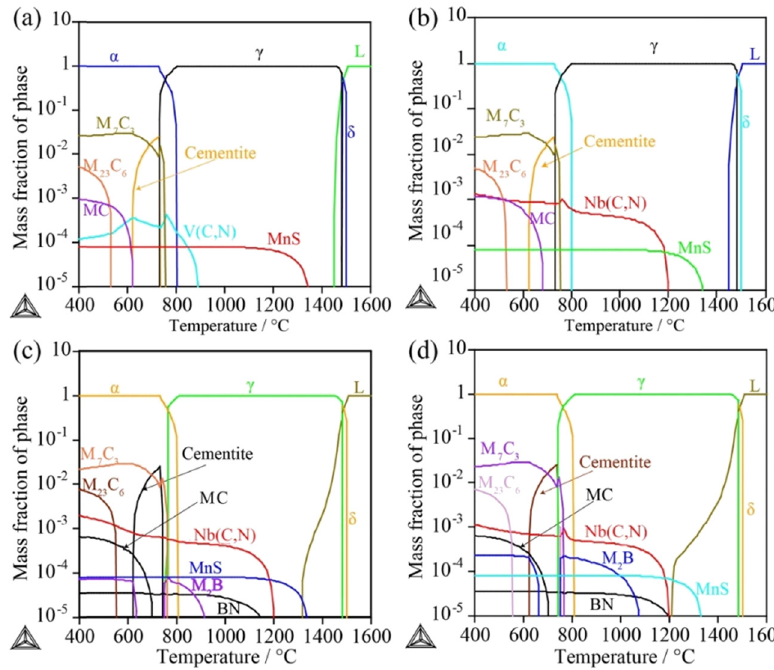
Figure 9: Thermodynamic calculation results of Thermo - Calc: ( a ) steel 1#; ( b ) steel 2#; ( c ) steel 3#; ( d ) steel 4#.